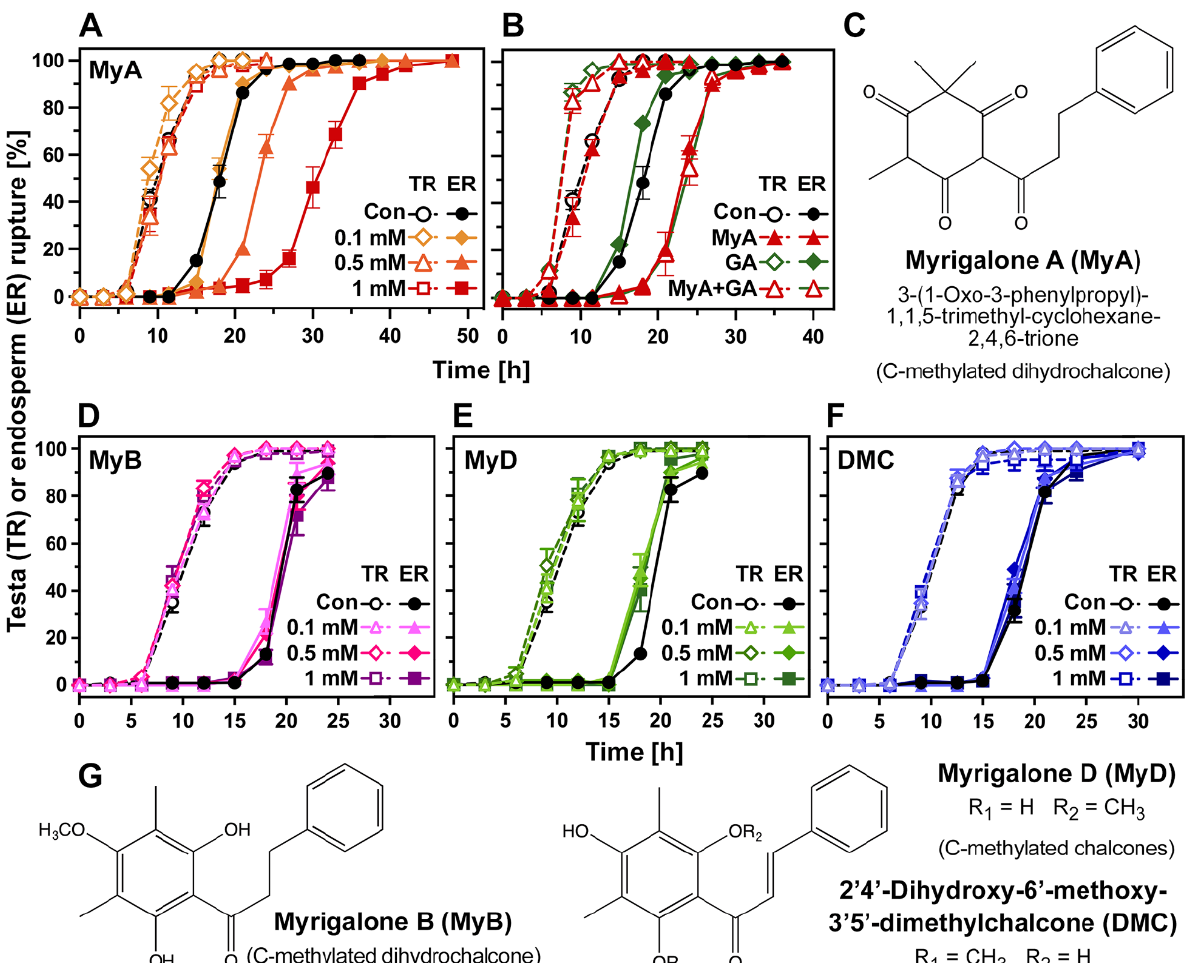
Figure 1. The effects of myrigalone A (MyA) and other dihydrochalcones and chalcones on Lepidium sativum seed germination. ( A ) The kinetics of testa rupture (TR) and subsequent endosperm rupture (ER) without (Con, control) or with MyA added at the concentrations indicated. Note that MyA inhibits ER but does not affect the timing of TR. ( B ) The effect of gibberellin (100 µM GA 4+7 ) on the inhibitory action of 0.5 mM MyA. ( C ) Chemical structure of the dihydrochalcone MyA. ( D – F ) Germination kinetics of cress seeds in the presence of three other myrigalone analoga. ( G ) Chemical structure of the MyB, MyD and DMC. Seeds were incubated at 20 °C in continuous white light. Mean ± SEM values for three replicates, each with ca. 30 seeds, are shown.